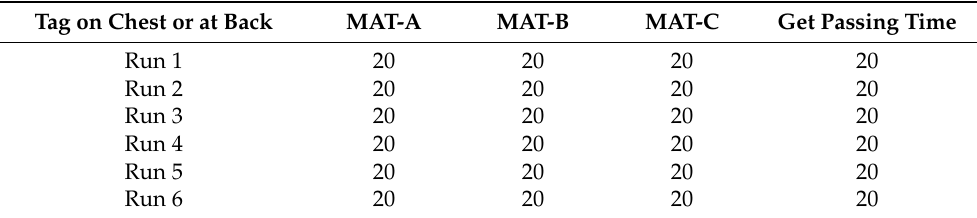
Table 19. The experiment in which 20 BLE Tags passed through three sets of MAT. Tag on Chest or at